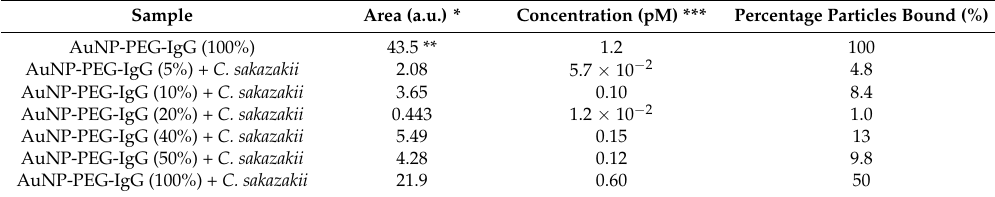
Table 1. Calculation of concentrations of targeted nanoparticles in C. sakazakii samples using the plasmonic extinction peak and the corresponding fractions of particles bound to bacteria for the data in Figure 4A.